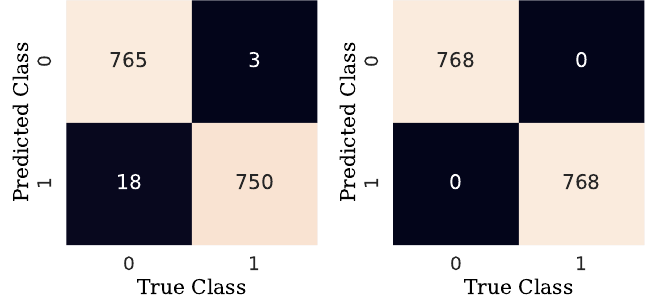
Figure 15. Confusion matrices for damage detection models 1 ( left ) and 2 ( right ).